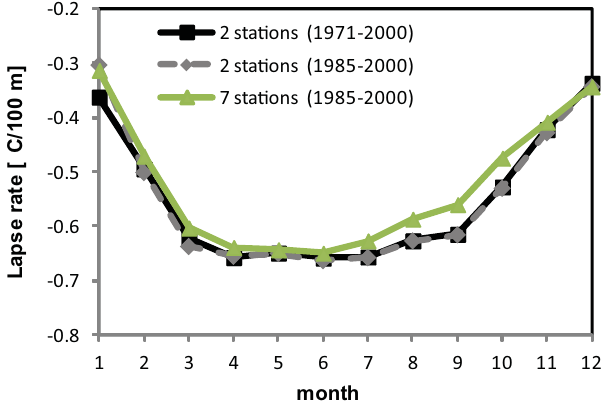
Fig. 3. Comparison of surface temperature lapse rate calculations derived from two and seven